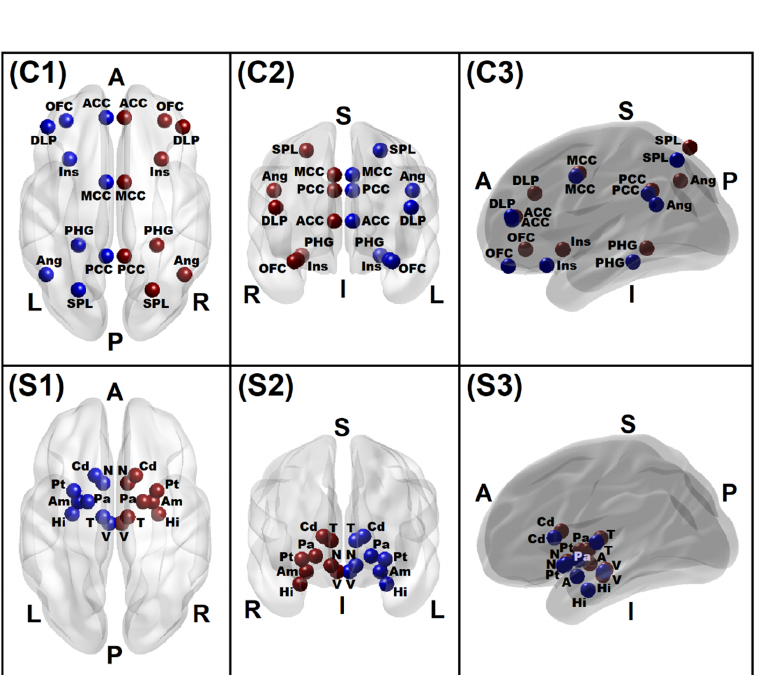
Figure 2. Brain reward network regions of interest comprising 16 cortical areas (top panels, C1 – C3 ) and 18 subcortical areas (bottom panels, S1 – S3 ), as listed in Table 1. Bilateral cortical regions: Insula (Ins), Parahippocampal Gyrus (PHG), Anterior Cingulate Cortex (ACC), Mid-Cingulate Cortex (MCC), Mid-Cingulate Cortex (MCC), Posterior Cingulate Cortex (PCC), Orbitofrontal Cortex (OFC), Angular Gyrus (Ang), Superior Parietal Lobule (SPL), Dorsolateral (PFC), and Dorsolateral Prefrontal Cortex (DLP). Bilateral subcortical regions: Ventral Tegmental Area (V), Nucleus Accumbens (N), Amygdala (A), Hippocampus (Hi), Caudate (Cd), Pallidum (Pa), Thalamus (T), and Putamen (Pt). Colors: Blue–Left hemispheric regions; Red–Right hemispheric regions. Views: C1/S1–Axial top view; C2/S2–Coronal front view; C3/S3–Sagittal left view. Directions: A–Anterior; P–Posterior; S–Superior; I–Inferior; L–Left; R–Right.